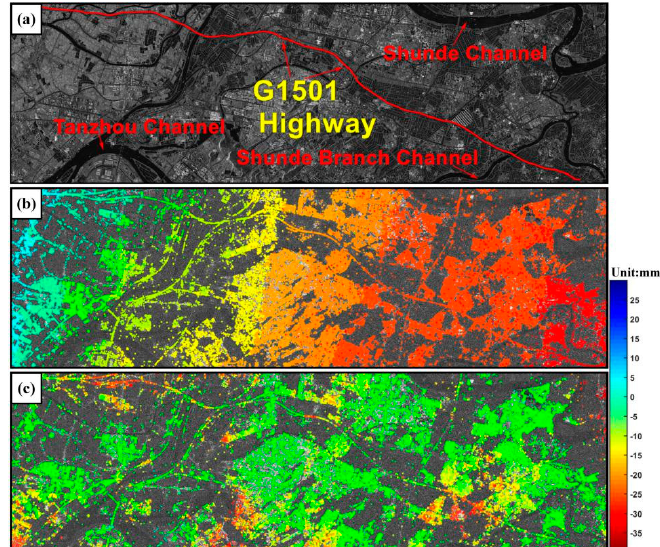
Figure 12. ( a ) The amplitude map over G1501 Highway; ( b ) The deformation map with obvious orbital error (27 October 2014 to 26 June 2015); ( c ) Corrected deformation map without orbital error (27 October 2014 to 26 June 2015).